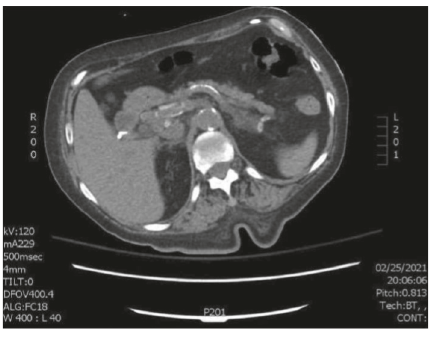
Figure 2: CTscan image of the abdomen without contrast showing resolution of the pancreatic mass after allopurinol